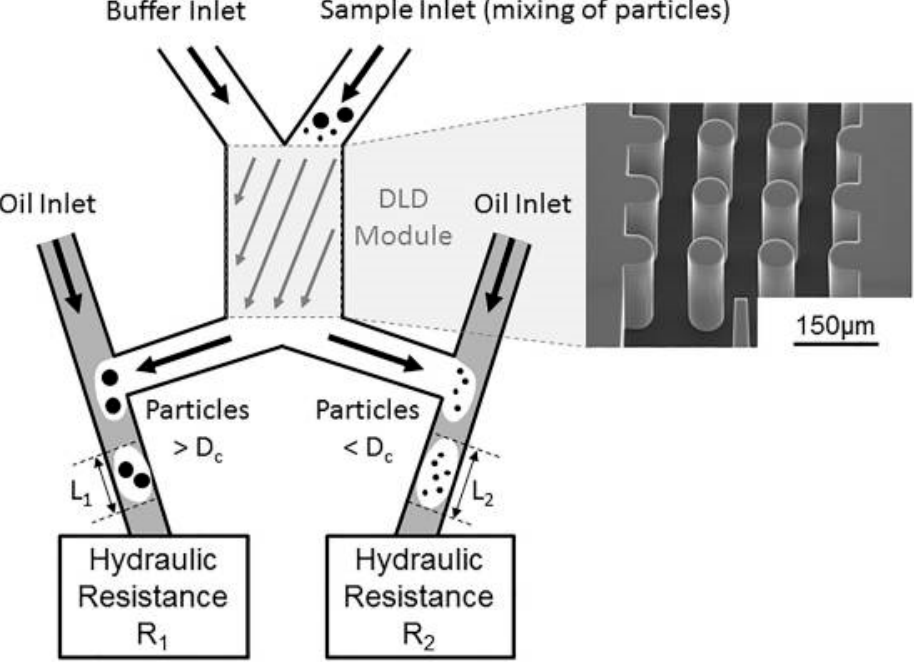
Figure 8. Particles larger than the critical diameter (D c ) were deviated towards the left outlet, while smaller particles flowed in the right outlet. The DLD outlet was connected to a T-junction with an oil inlet, for generation of droplets of lengths L 1 and L 2 . (Reprinted from [58]).